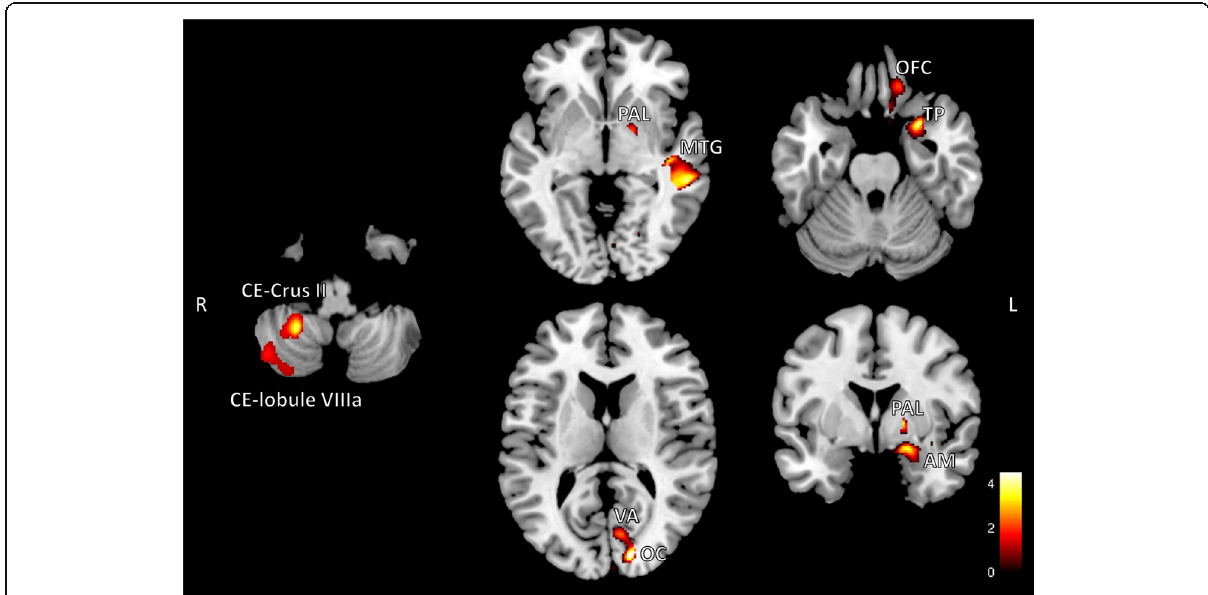
Fig. 2 SPM regions superimposed on a high-resolution T1-weighted scan show decreased GM volume in patients with CM compared to HCs ( p <0.005 uncorrected). Areas with significantly reduced GM volume are observed in the cerebellum (CE), left primary occipital cortex (OC), visual association area (VA), left middle temporal gyrus (MTG), left amygdala (AM), left temporal pole (TP), left pallidum (PAL), and left orbitofrontal cortex (OFC). Labels of the cerebellum stem from the Spatially Unbiased Infraorbital Template atlas. L=left, R=right